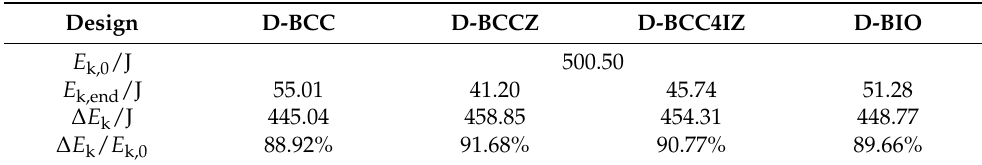
Table 4. The E k value of four designs.